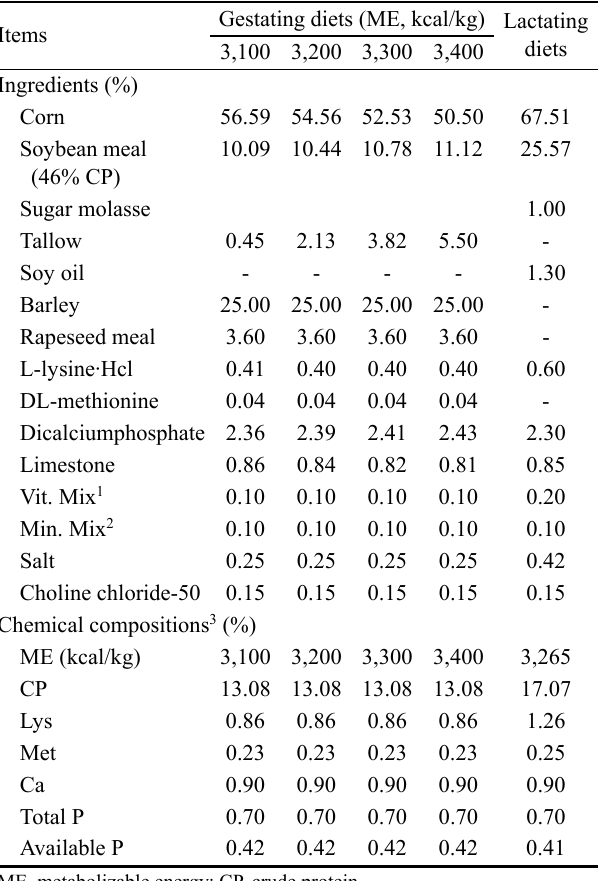
Table 1. Formula and chemical composition of gestating and lactating diets (%)